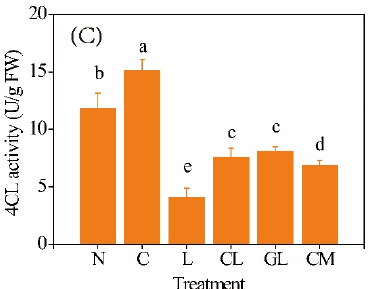
Figure 2. Activities of PAL ( A ), C4H ( B ), and 4CL ( C ) in soybean sprouts (n = 3). N: NaCl; C: NaCl + CaCl 2 ; L: NaCl + LaCl 3 ; CL: NaCl + CaCl 2 + LaCl 3 ; GL: NaCl + GABA + LaCl 3 ; CM: NaCl + CaCl 2 + 3-mercaptopropionate (3-MP). Values bearing different letters in each line are significantly different ( p < 0.05).